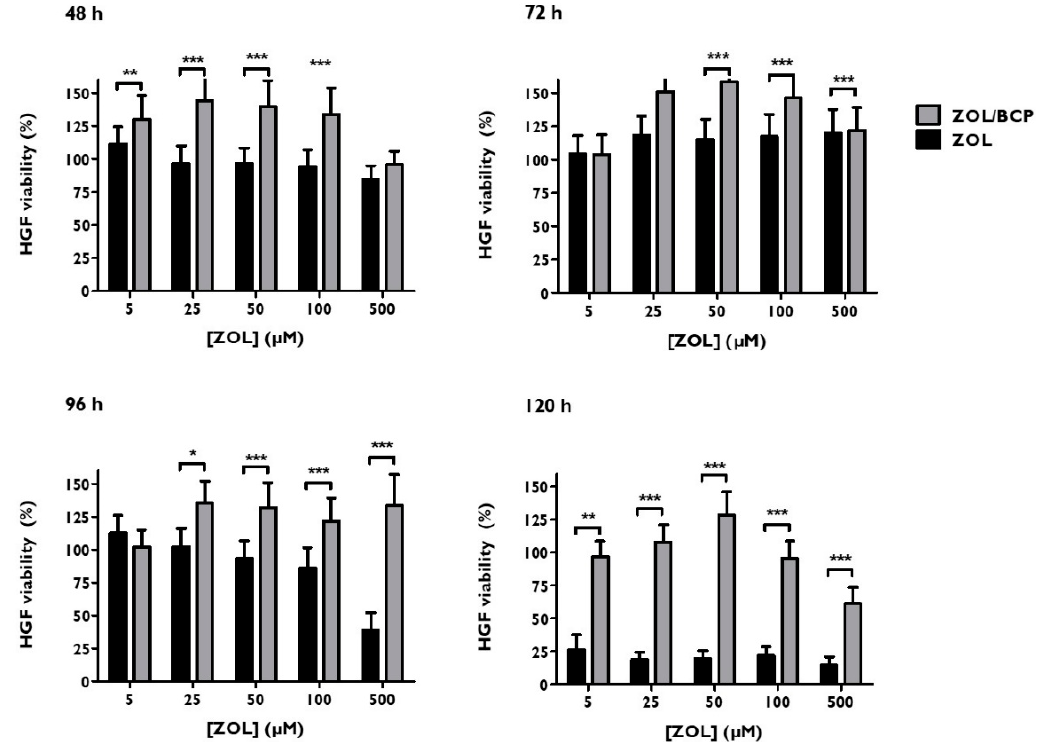
Figure 6. HGF viability, 48 h, 72 h, 96 h and 120 h after treatment with ZOL and with ZOL/BCP. The results represent the mean and standard deviation of at least six tests. Significant differences are represented with *, where * means p < 0.05, ** means p < 0.01, and *** means p < 0.001.